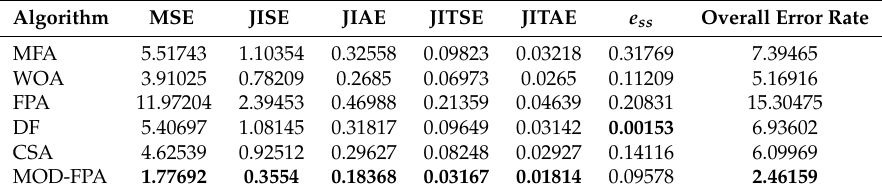
Figure 9. Tracking error for random load torque, varying set rotor speed and nominal parameters condition. Table 9. Performance analysis for speed tracking task for random load torque, varying set rotor speed and nominal parameters